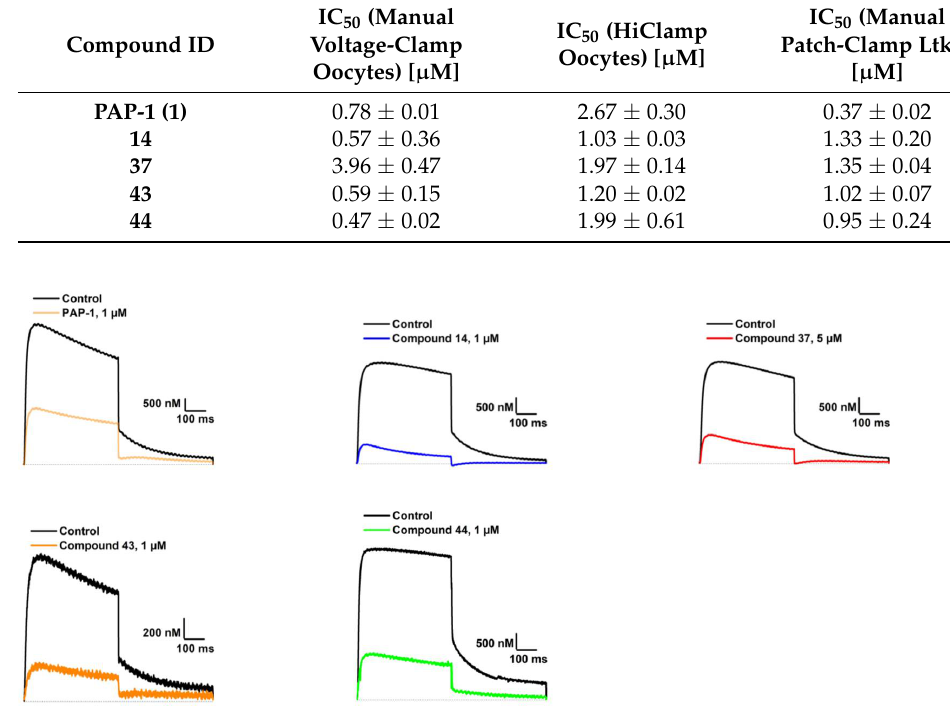
Figure 3. Raw traces of K V 1.3 currents in control conditions in ND96 (black line) and after addition of PAP-1 (light orange line), 14 (blue line), 37 (red line), 43 (orange line), and 44 (green line). The dotted line indicates the zero current level. Measured by manual voltage clamp on Xenopus laevis oocytes.